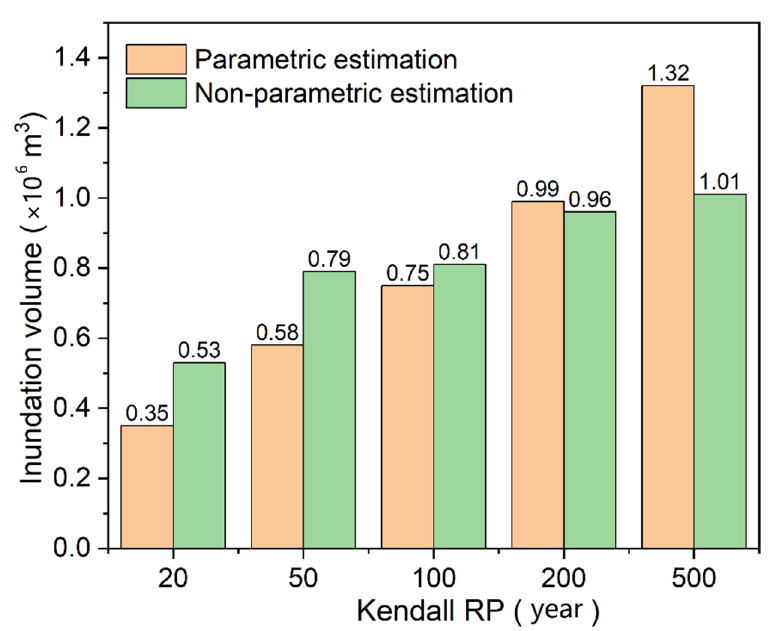
Figure 12. Comparison of inundation volumes for parametric and non-parametric estimation.